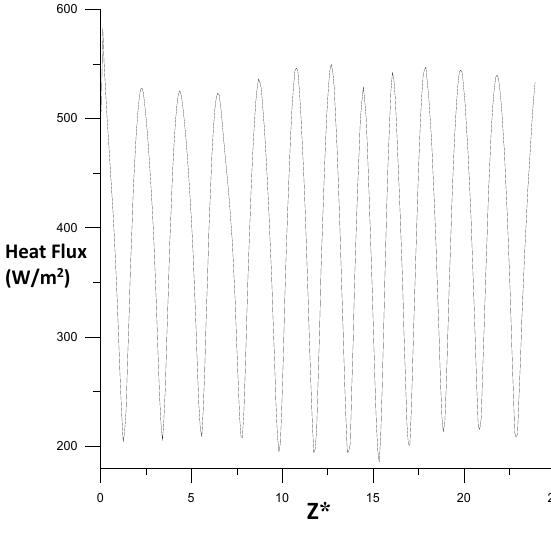
Figure 11. Heat flux along axial direction at